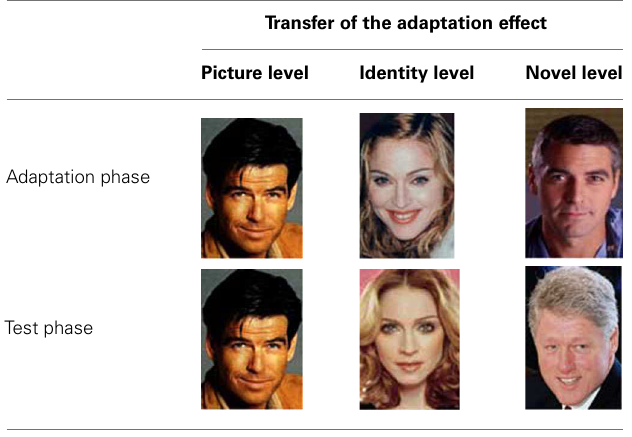
Table 3 | Different transfer levels of adaptation effects as realized in studies of Carbon and colleagues (Carbon et al., 2007b; Carbon and Ditye, 2011, 2012; Strobach et al.,